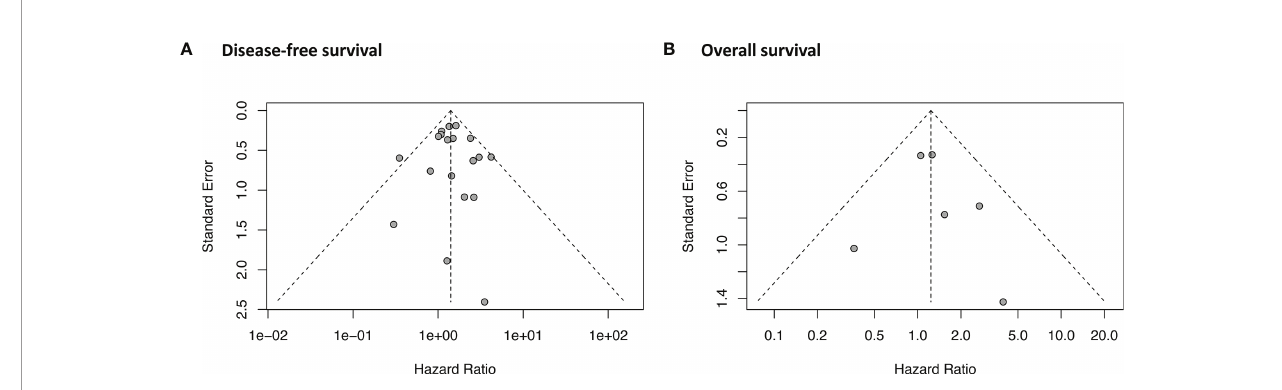
FIGURE 5 | Publication bias of (A) disease-free survival and (B) overall